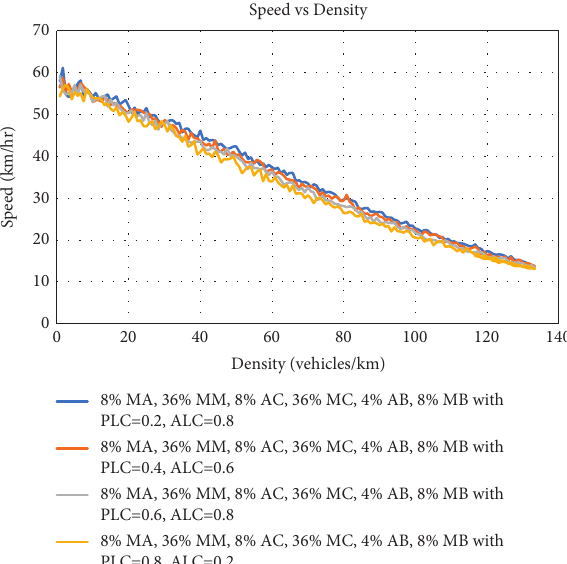
Figure 12: Speed vs. density fundamental diagrams for different compositions of MA, MM, AC, MC, AB, and MB with different values of ALC and